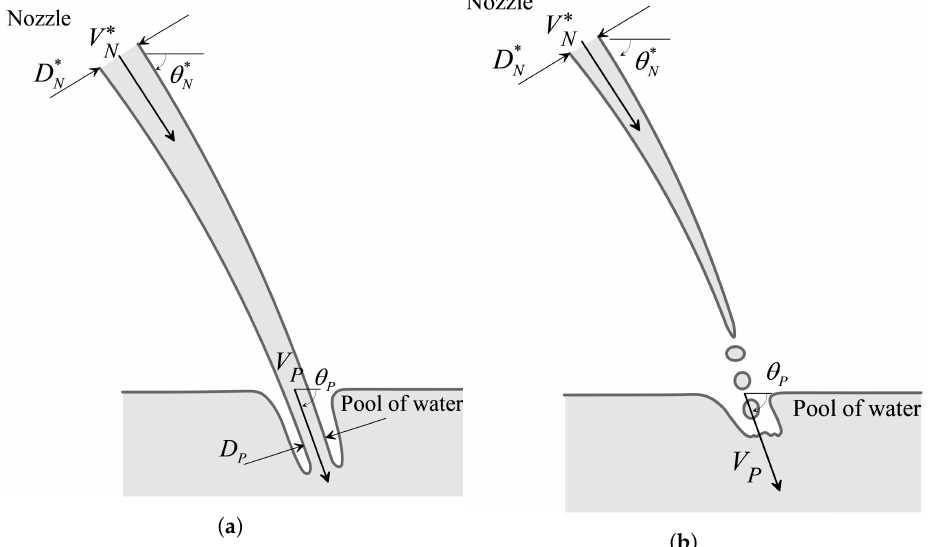
Figure 1. The plunging liquid jet when it: ( a ) maintains the cylindrical shape; ( b ) breaks into droplets. In addition, the falling jet causes a deviation from the state of equilibrium in the tank (in the gravitational field), which generates an oscillatory motion due to the gravity and surface tension (capillary forces). This motion propagates along the water surface in waves known as gravity–capillary waves, which are common in nature and often referred to as ripples